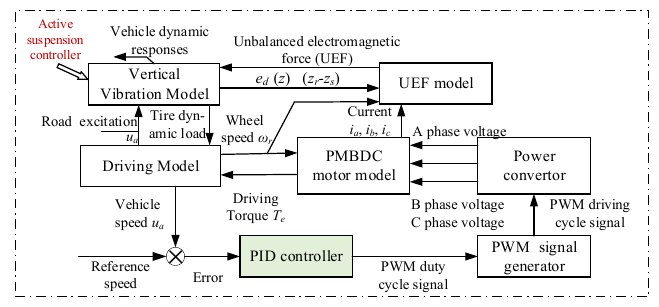
Figure 1. Hub-driven electric vehicle model.